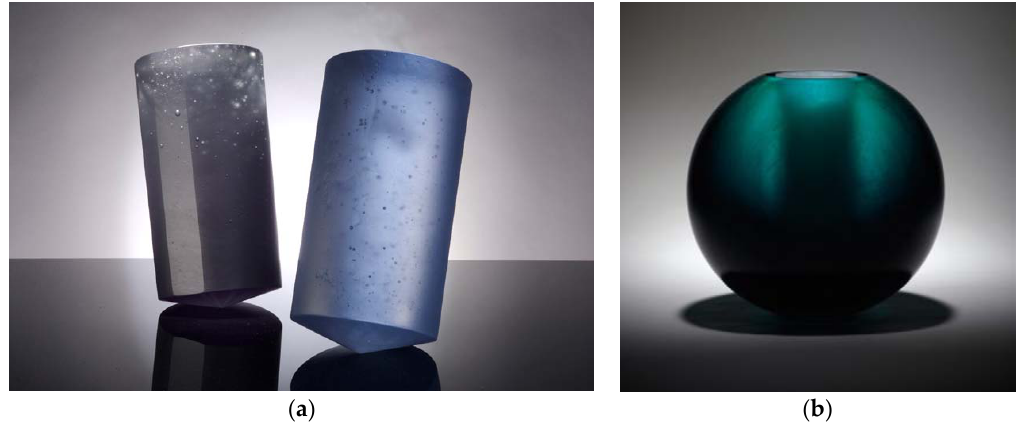
Figure 2. Appearance of rounded forms. ( a ) Heike Brachlow, Mirrormovement, 2006, cast glass, dimensions 33.5 × 16.5 × 16.5 cm; 30.5 × 16.5 × 16.5 cm. Photograph by Sylvain Deleu, courtesy of the artist. ( b ) Bruno Romanelli, Caliban, 2018, cast glass, 24 × 25 × 25 cm. Photograph by Andy Smart at AC Cooper, courtesy of the